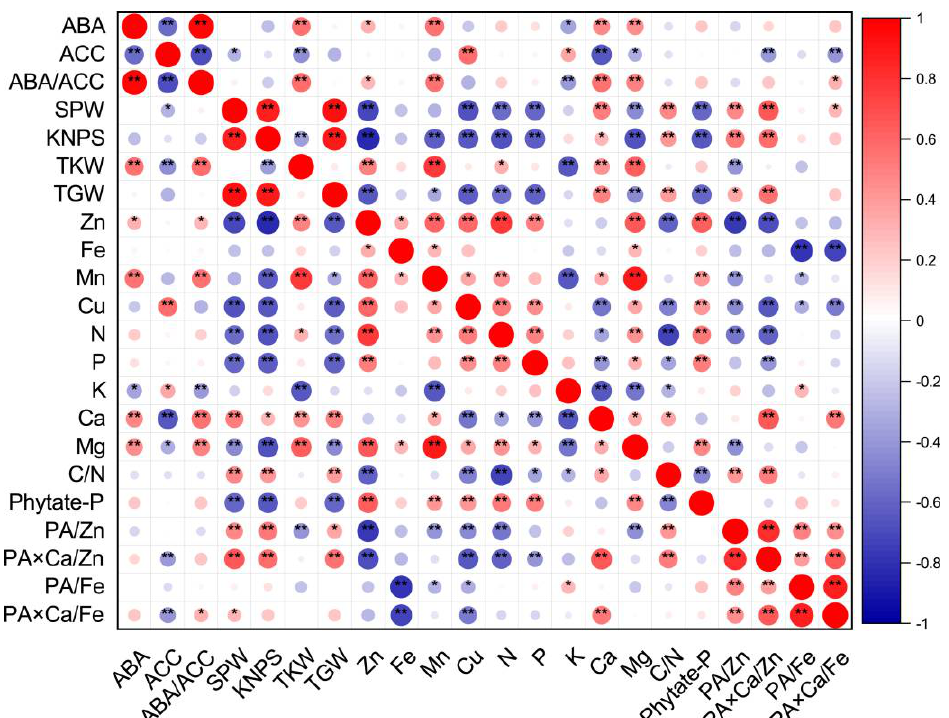
Figure 1. Corrplot representing correlation among measured grain phytohormones (concentrations of ABA and ACC, and ratios of ABA/ACC), grain yield traits and nutritional parameters (concentrations and ratios) of wheat crop across different soil Zn applications, cultivars and source–sink treatments ( n = 48). Positive correlations are displayed in red and negative correlations are displayed in blue. The color legend on the right hand side of corrplot shows correlation coefficients and the corresponding colors. The intensity of the color and the circle size are proportional to the correlation coefficients. “*” and “**” indicate significant correlations at p ≤ 0.05 and p ≤ 0.01, respectively. The abbreviations are as follows: single panicle weight (SPW), kernel number per spike (KNPS), thousand kernel weight (TKW), total grain weight (TGW), concentrations of abscisic acid (ABA), the ethylene precursor 1-aminocylopropane-1-carboxylic acid (ACC), Zn, Fe, Mn, Cu, N, P, K, Ca, Mg and phytate-P, ratios of C/N and ABA/ACC, and molar ratios of phytic acid (PA)/Zn, PA × Ca/Zn, PA/Fe and PA × Ca/Fe in wheat